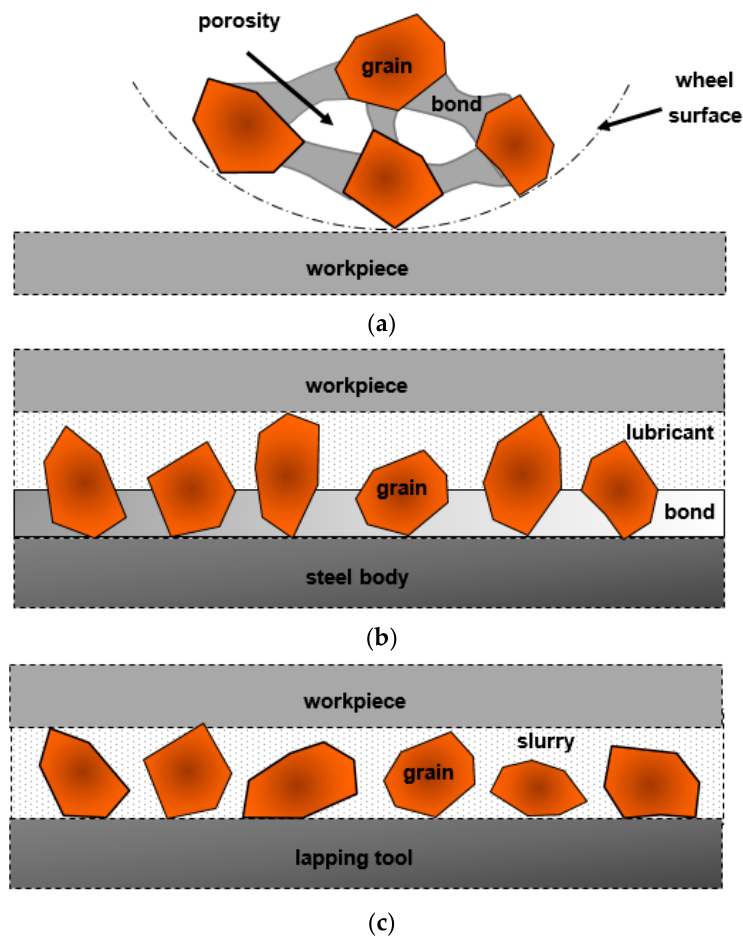
Figure 2. Schematic illustrations of fixed abrasives in a porous grinding wheel ( a ) and an electroplated tool ( b ), as well as loose abrasive used in lapping ( c ).